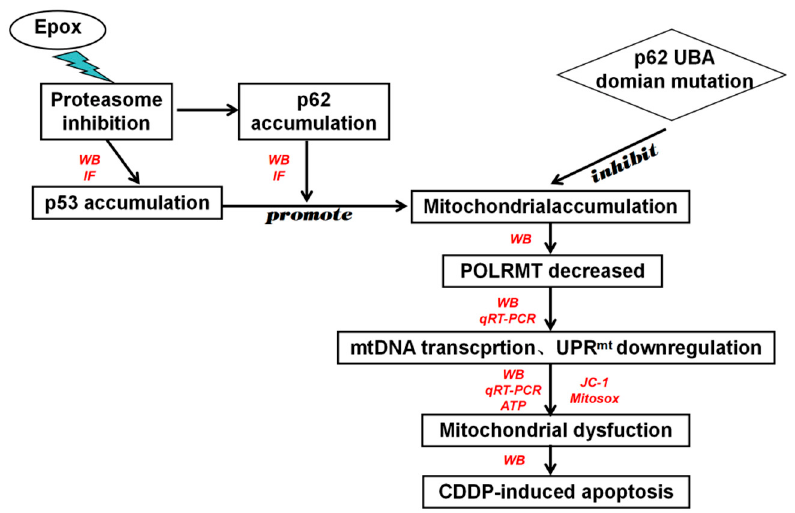
Figure 8. p62 promotes the mitochondrial localization of p53 through its UBA domain and participates in regulating the sensitivity of ovarian cancer cell to cisplatin. After the combined use of epox and CDDP, p62 and p53 accumulate in the mitochondria, leading to cell death by downregulating of mitochondrial DNA transcription, UPR mt , mitochondrial dysfunction and decreased sensitivity of A2780 cells to cisplatin, which was mediated by the UBA domain of p62. The green lightning symbol represents the use of the drug, the red text represents the detection method, the rectangle represents the experimental result, the circle represents the drug treatment, and the rhombus represents the transfection of p62 lacking the UBA domain.